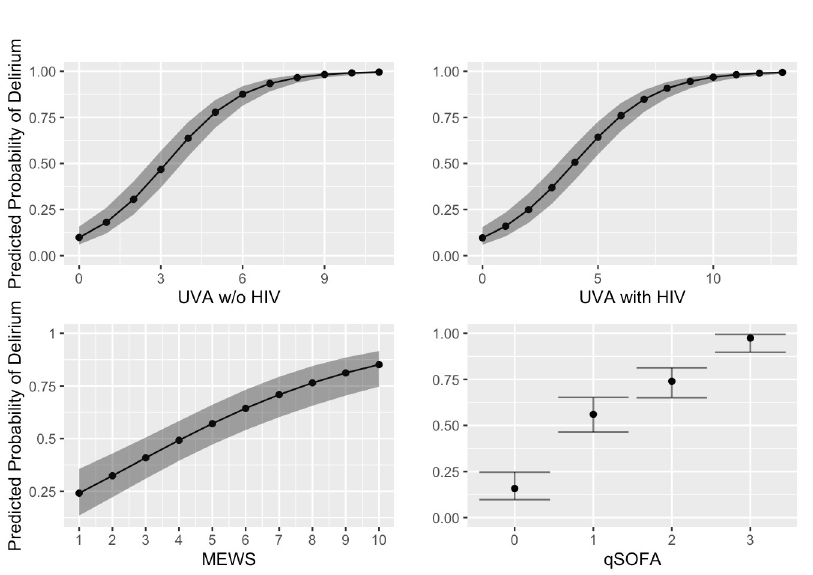
Fig 1. Predicted probability of delirium by severity of illness score at